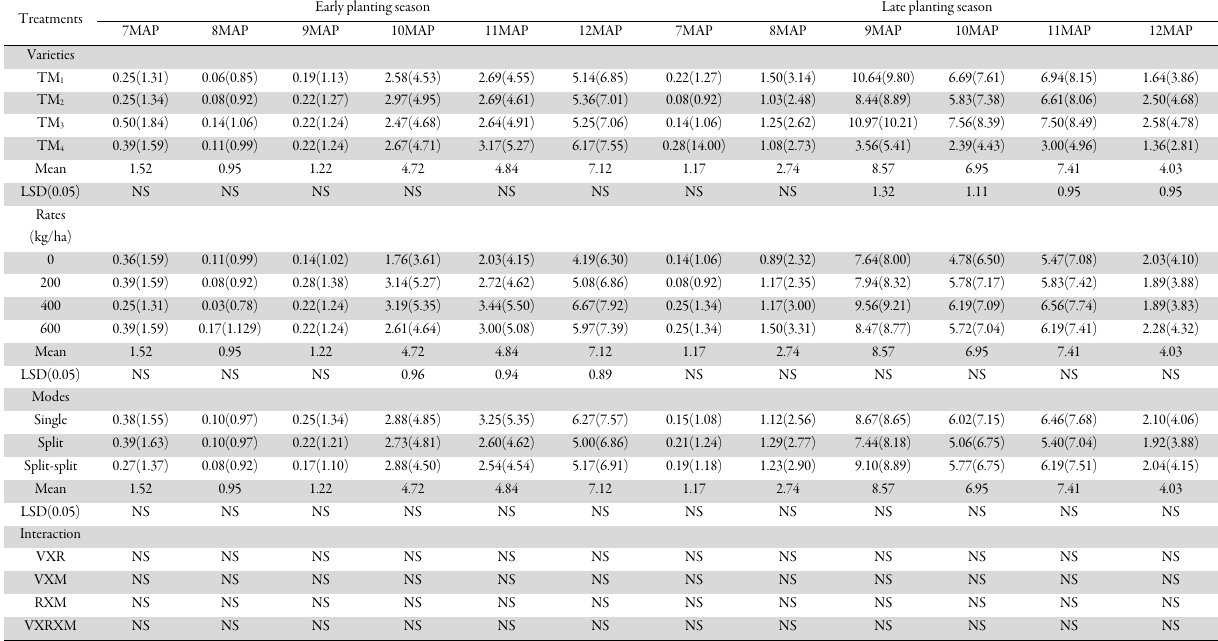
Table 4. Effect of varieties, rate, mode of NPK fertilizer and their interactions on the incidence of Z. variegatus on the field Treatments